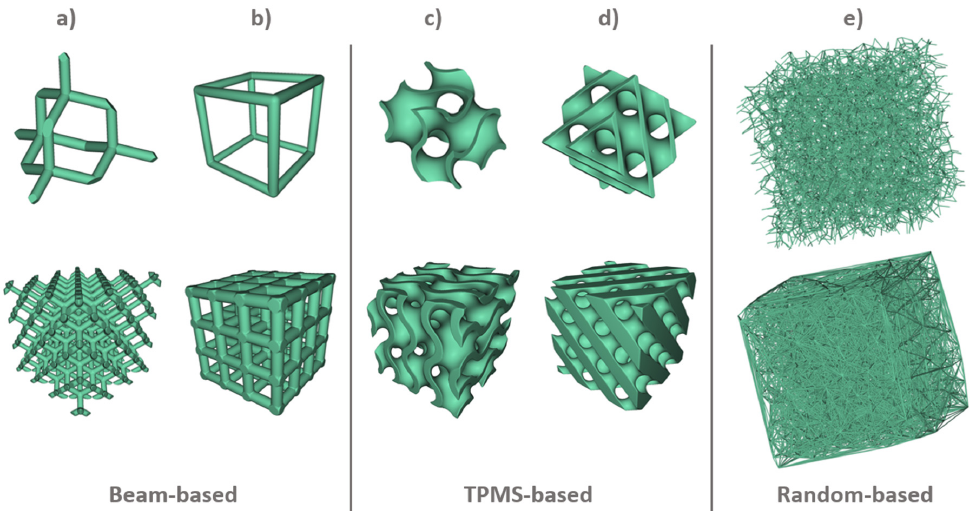
Figure 8. Some examples of unit cells with their corresponding meta-biomaterial scaffold below: ( a ) diamond beam-based unit cell; ( b ) cubic beam-based unit cell; ( c ) Gyroid triply periodic minimal surface based (TPMS-based) unit cell; ( d ) Diamond TPMS-based unit cell; and ( e ) Voronoi (top) and Delaunay (bottom) irregular porous structures.